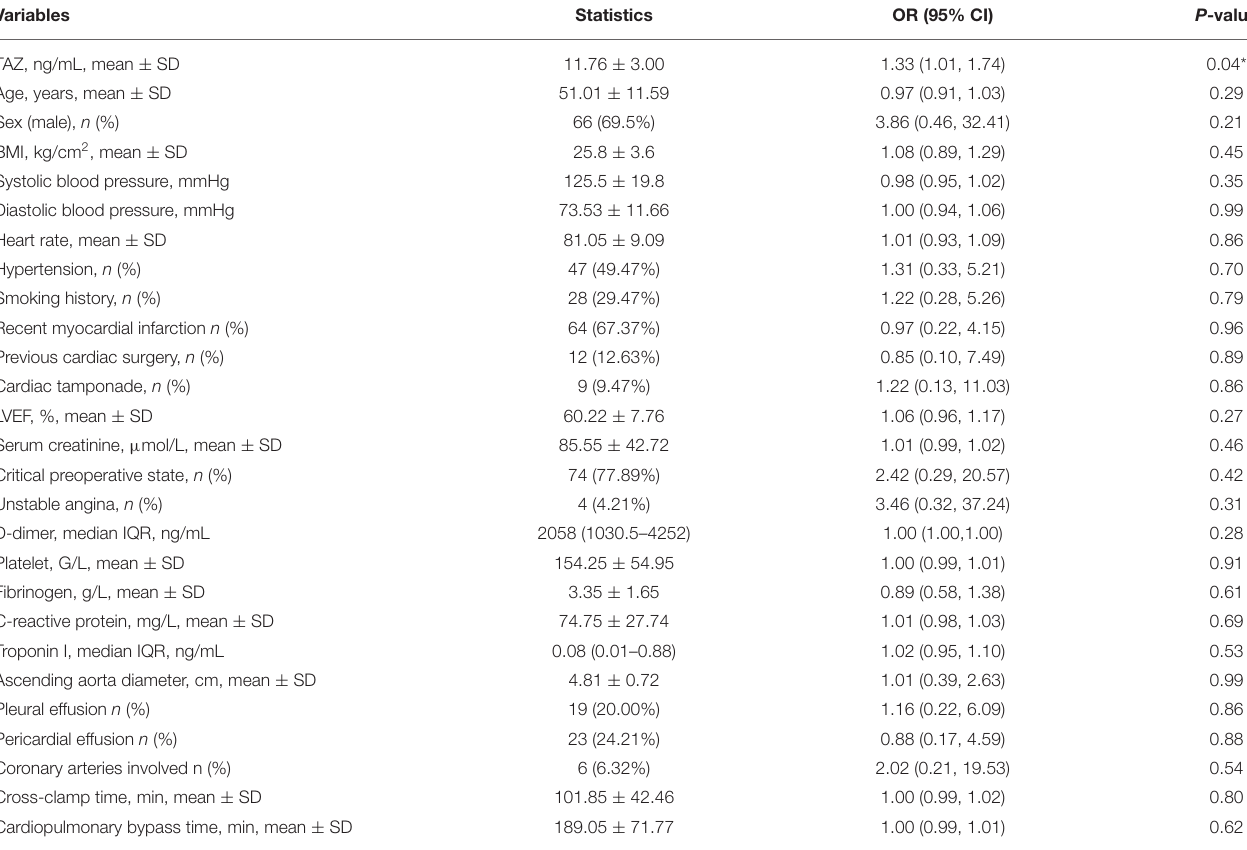
TABLE 2 | The unadjusted association of clinical characteristics with in-hospital mortality ( N = 95).